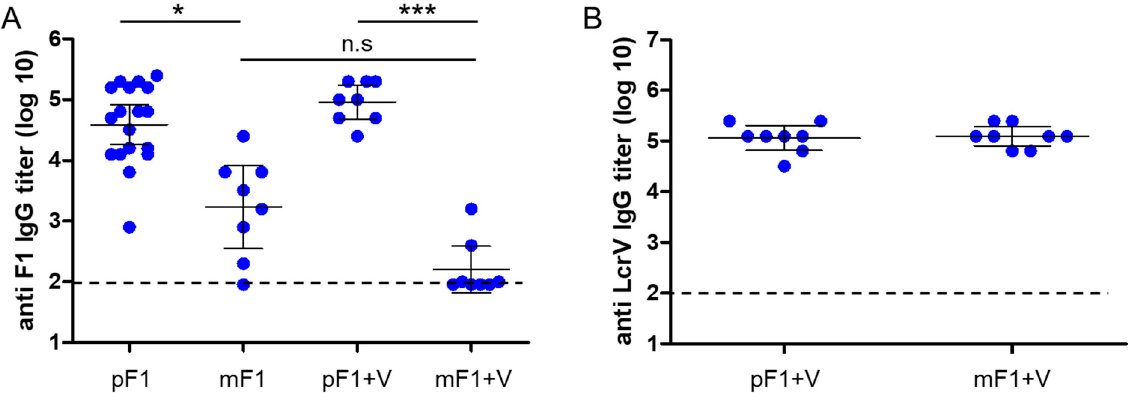
Figure 4. Longevity of the serological response following a single vaccination with monomeric F1 and polymeric F1 either alone or with LcrV. ( A ) Anti-F1 IgG titers measured in the sera of CD-1 female mice 180 days post a single vaccination with polymeric F1 (pF1, 80 µg/mouse), polymeric F1 + LcrV (pF1 + V, 80 µg each/mouse), monomeric F1 (mF1, 80 µg/mouse), and monomeric F1 + LcrV (mF1 + V, 80 µg each/mouse). ( B ) Anti-LcrV IgG titers that were measured in the sera of the mice as described in ( A ). The dashed horizontal line marks the limit of detection. n.s. = nonsignificant, * = p < 0.05, *** = p < 0.001.